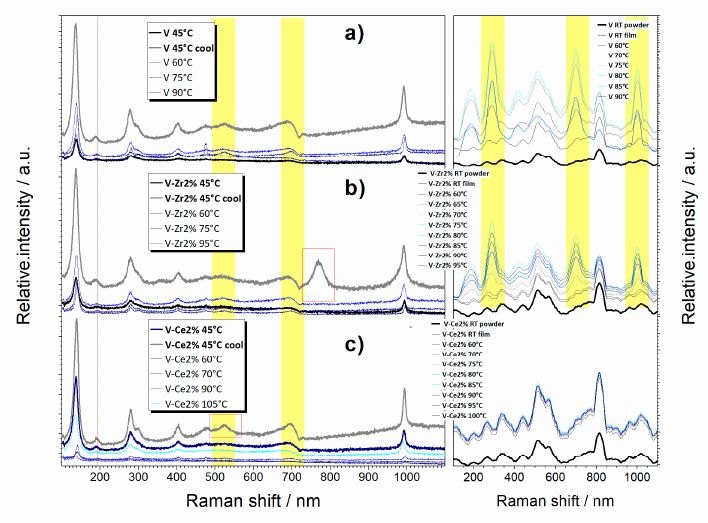
Figure 5. Cycling of micro Raman spectroscopy for ( a ) V, ( b ) V-Zr2%, and ( c ) V-Ce2%. Insets: cycling of in-operando Raman spectroscopy for pure, zirconium doped, and cerium-doped vanadium oxide sample.